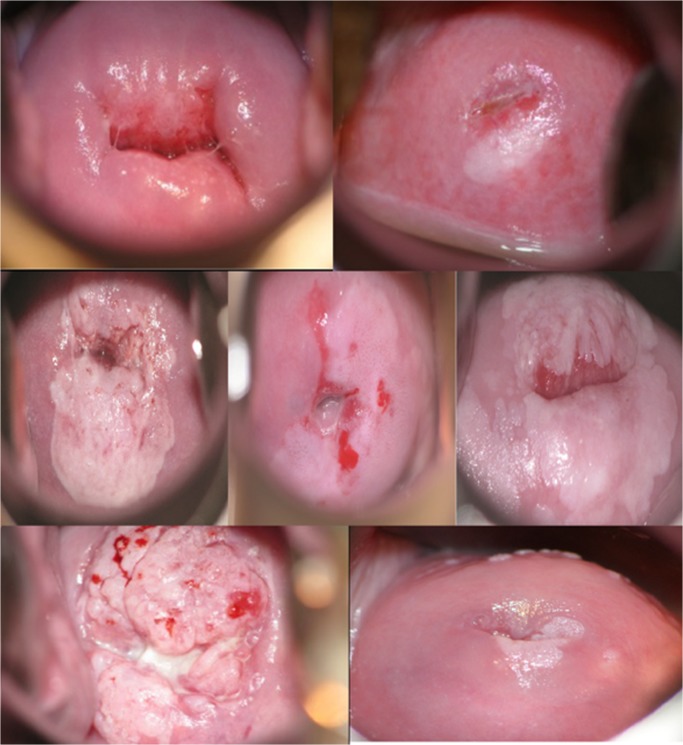
Images of VIA negative, VIA positive-cryotherapy eligible and VIA positive-cryotherapy ineligible lesions from women undergoing screening in the Cervical Cancer Prevention Program in Zambia (CCPPZ).
Notes: Using the following criteria, CCPPZ nurses classify VIA tests results as VIA negative, VIA positive eligible for local ablation with cryotherapy, or VIA positive ineligible for cryotherapy requiring physician evaluation.

VIA negative: Absence of an acetowhite lesion with at least one distinct border (Top Panel, Left)
VIA positive, eligible for cryotherapy: Acetowhite lesion with at least one distinct border, located within or adjacent to the transformation zone, that: occupies <75% or <3 quadrants of the surface of the ectocervix, is completely visualized, can be completely covered by the largest available cryoprobe tip, has no evidence of abnormal vasculature (punctations, mosaicism, atypical blood vessels) and is not suspicious for ICC (Top panel, right)
VIA positive, ineligible for cryotherapy: Acetowhite lesion with at least one distinct border, located within or adjacent to the transformation zone, that has any of the following characteristics:
Occupies ≥3 quadrants or ≥75% of the surface of the ectocervix (Middle panel, left)
Has evidence of abnormal vasculature (punctations, mosaicism, atypical blood vessels) (Middle panel, center)
Cannot be completely covered by the largest available cryoprobe tip (Middle panel, right)Is suspicious for invasive cervical cancer (Bottom panel, left)Extends into the endocervical canal beyond complete visualization (Bottom panel, right)